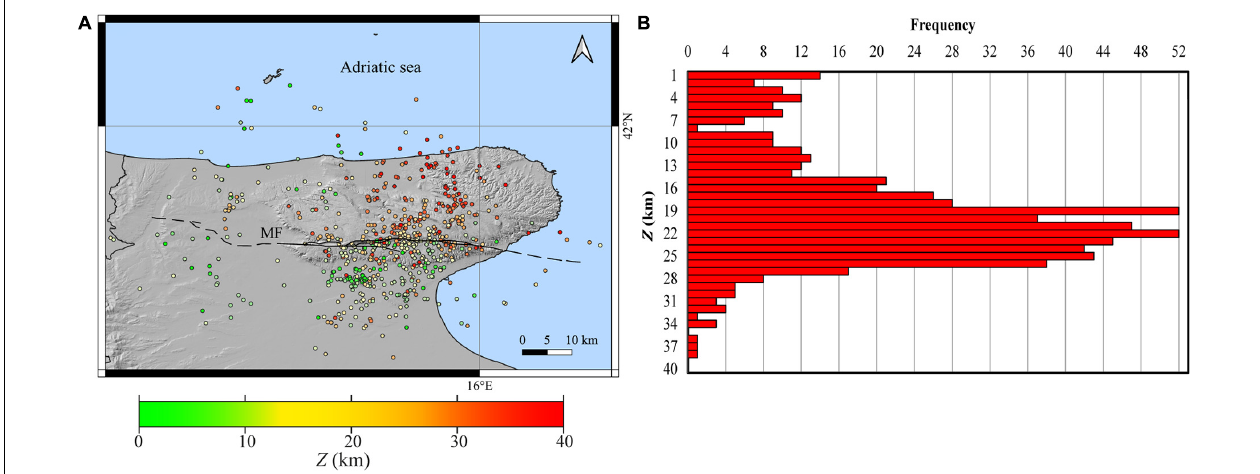
FIGURE 2 | (A) Epicenters of the 635 microearthquakes recorded between April 2013 and June 2020 and listed in Supplementary Table 1 . Different colors refer to depth as indicated in the color scale bar; (B) Frequency histogram of the hypocenters.